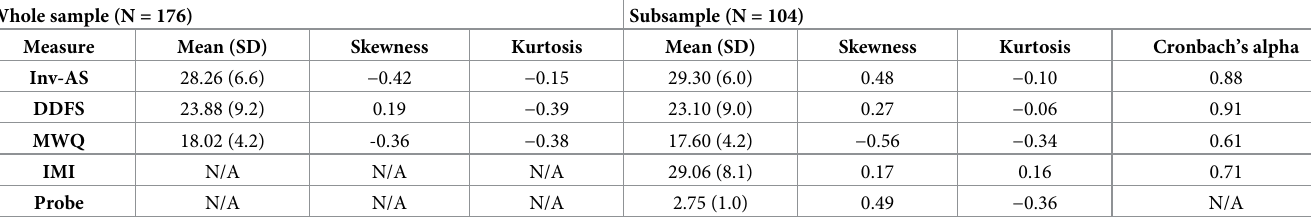
Table 1. Descriptive statistics of trait level indices for mind wandering in total and